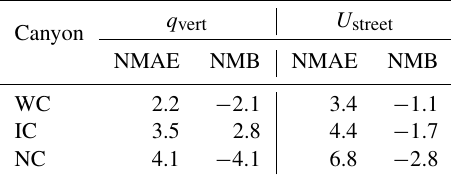
Table 2. Statistical indicators (normalized mean absolute er- ror, NMAE, and bias, NMB, in percent) for the comparison of Code_Saturne and MUNICH q vert and U street